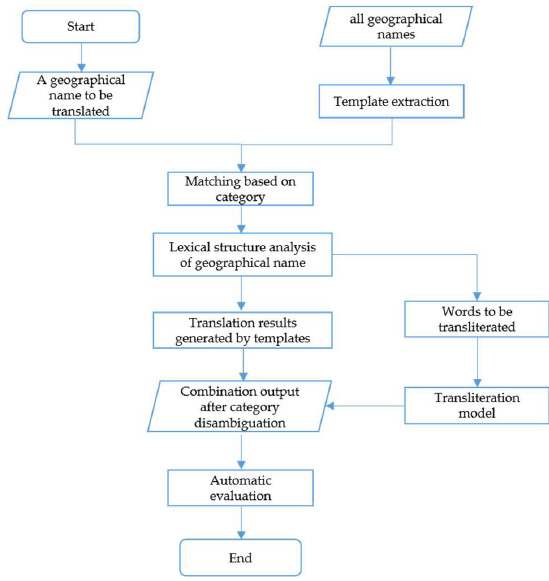
Figure 7. English geographical name machine translation and evaluation flow chart.